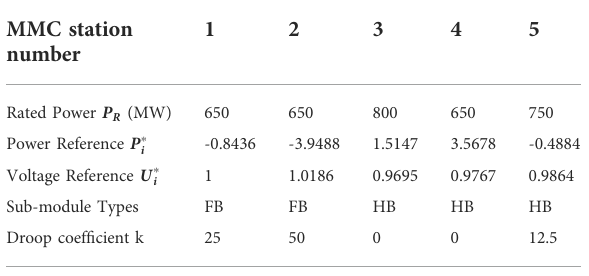
TABLE 7 MMC parameters (in